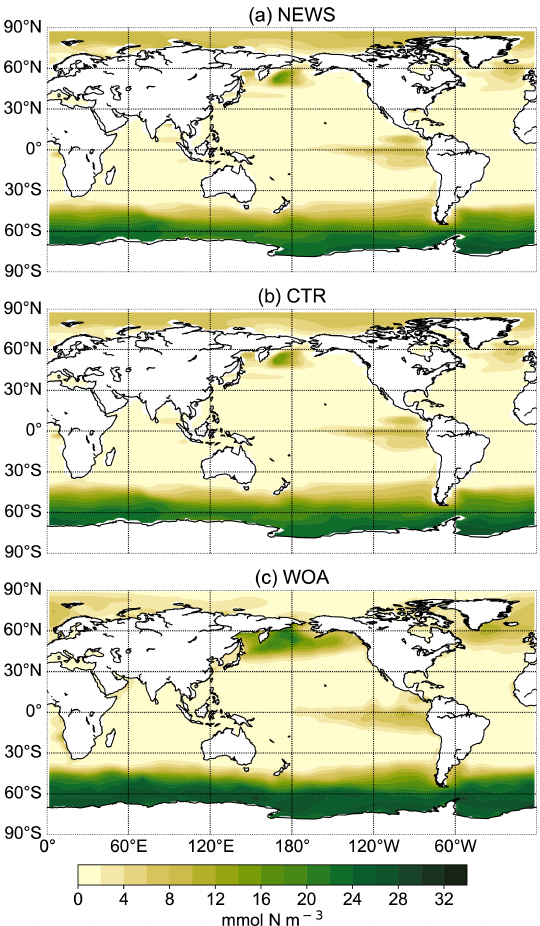
Figure 4. Surface NO 3 concentrations for simulations UVic NEWS (a) and UVic control (b) and from observations from the World Ocean Atlas (Garcia et al., 2019) (c)